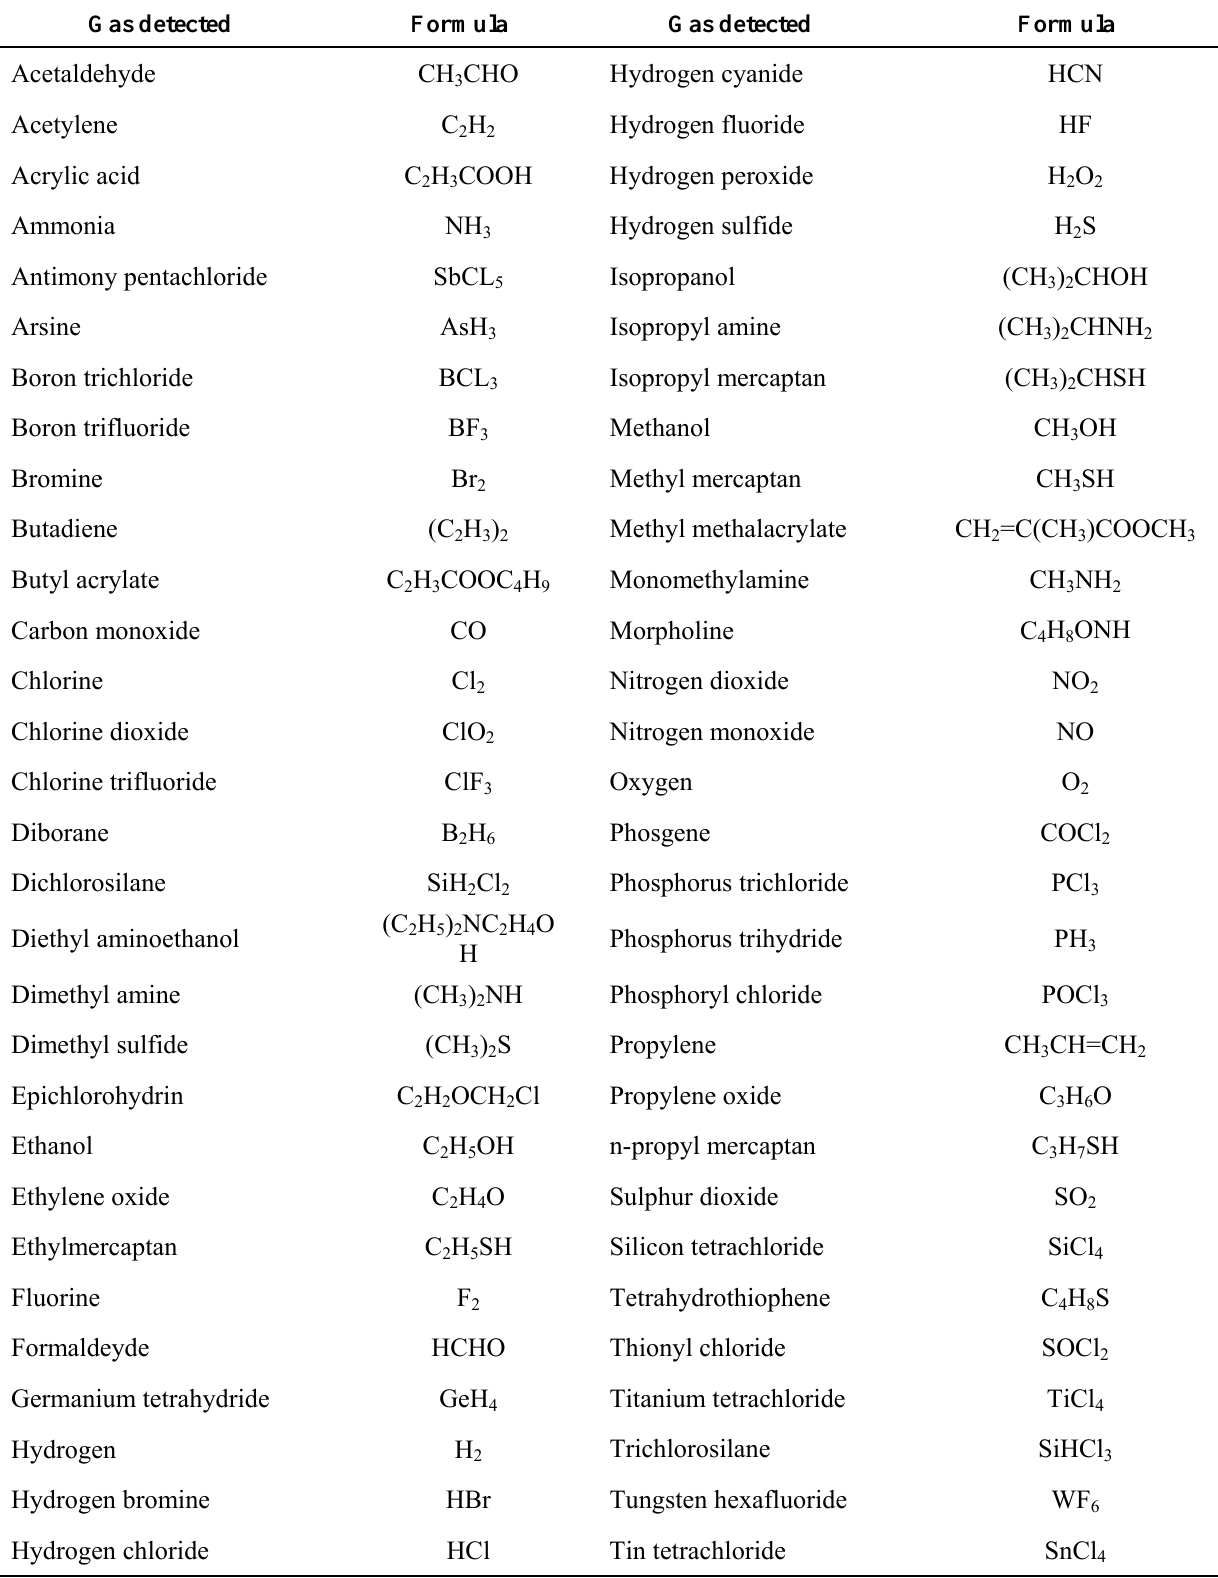
Table 4. A partial list of gases that have been detected using electrochemical (EC)